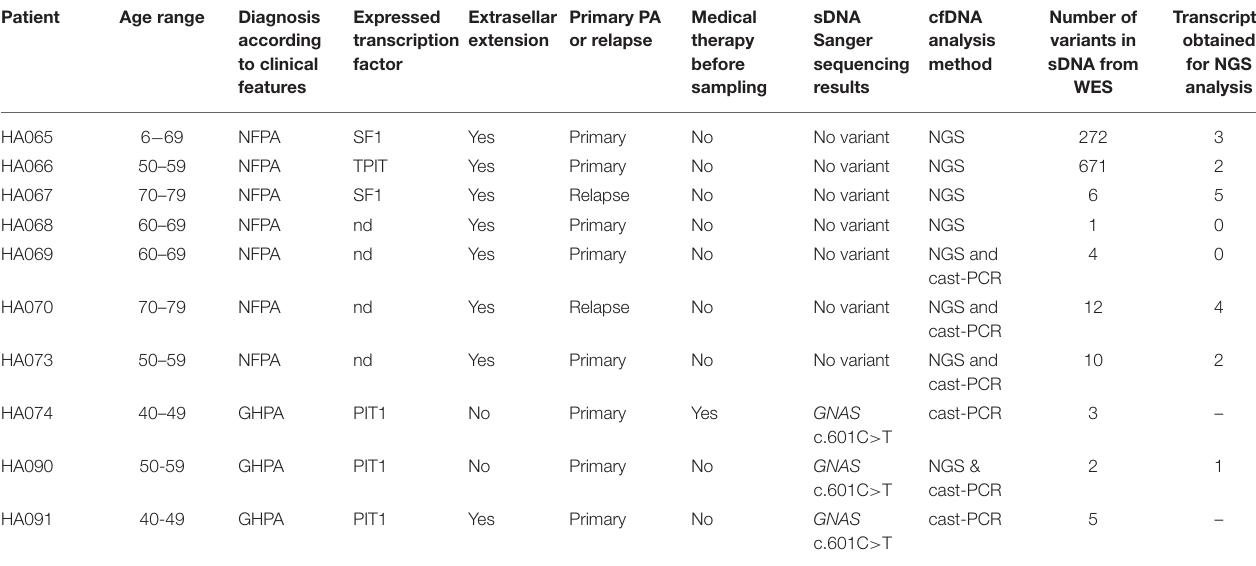
TABLE 1 | Study sample description.